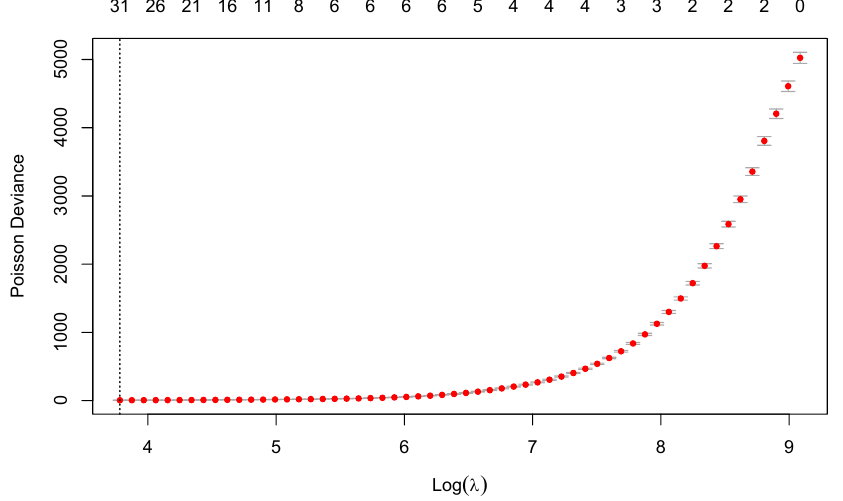
Figure 2. Cross-validation plot of the glmnet algorithm for α = 0.5. Forecast of mortality can then be obtained by extrapolation of the fitted mortality surface. Figure 3 represents the crude death rates (the data) and the forecast death rates until 2050. At first glance, we observe that the fitted model with only 31 parameters performs well at forecasting mortality rates. In particular, forecast death rates extend properly the observed levels of mortality rates represented by the different color levels in Figure 3.